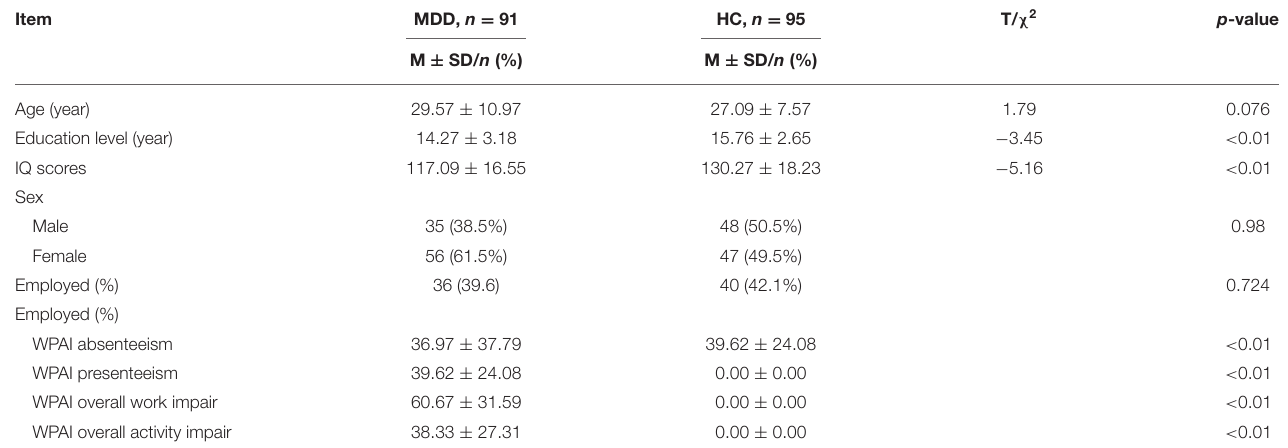
TABLE 1 | Demographic information between MDD and HC.